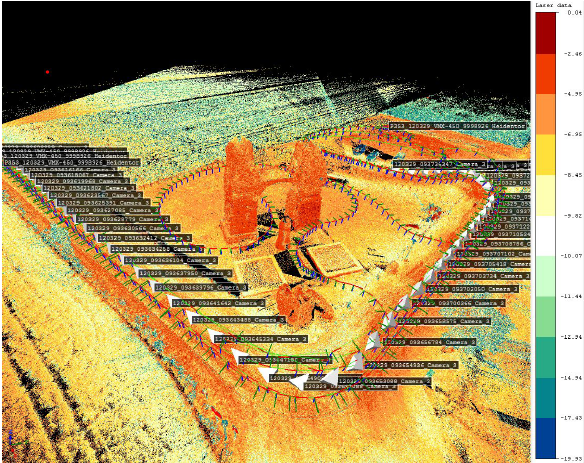
Figure 3: Overview of the acquired MLS data of the study site: Heidentor, Carnuntum (Austria). The point cloud is coloured based on the recorded laser reflectance